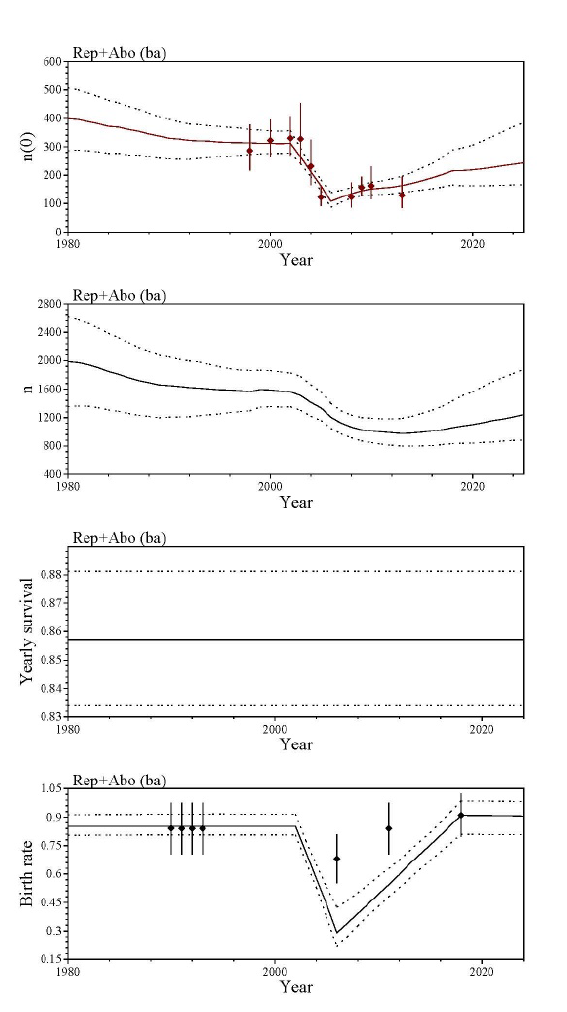
Figure 4. Harp seals in the Barents Sea/White Sea: Projected medians and 90% credibility intervals for Rep+Abo (bat) - the 4th version of the Bayesian age-structured and density regulated model, which assumed that the crash was due to a decline in fecundity only, with the years with early data having no abortion or early (before count) pup mortality, while the latter were significant around the crash. Data from ICES